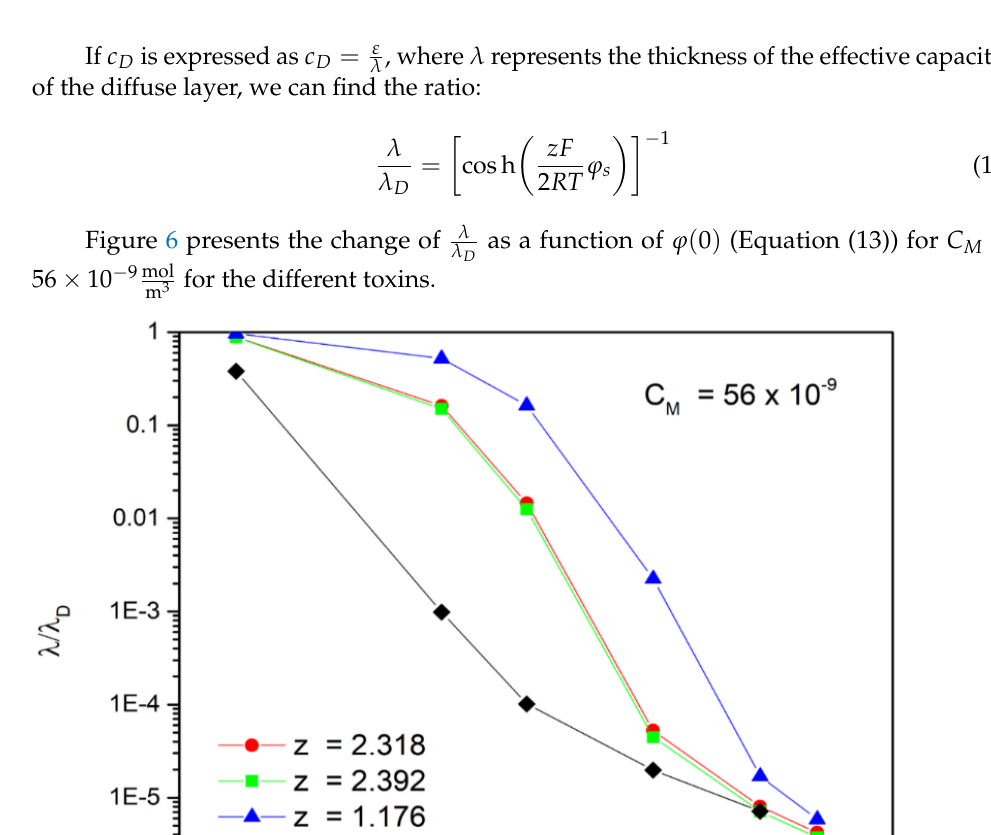
for all the toxins as a function of 𝜑(0) (V) for 𝐶 (cid:3014) = 56 × 10 (cid:2879)(cid:2877) (cid:2923)(cid:2925)(cid:2922) (cid:3090) (cid:3253)